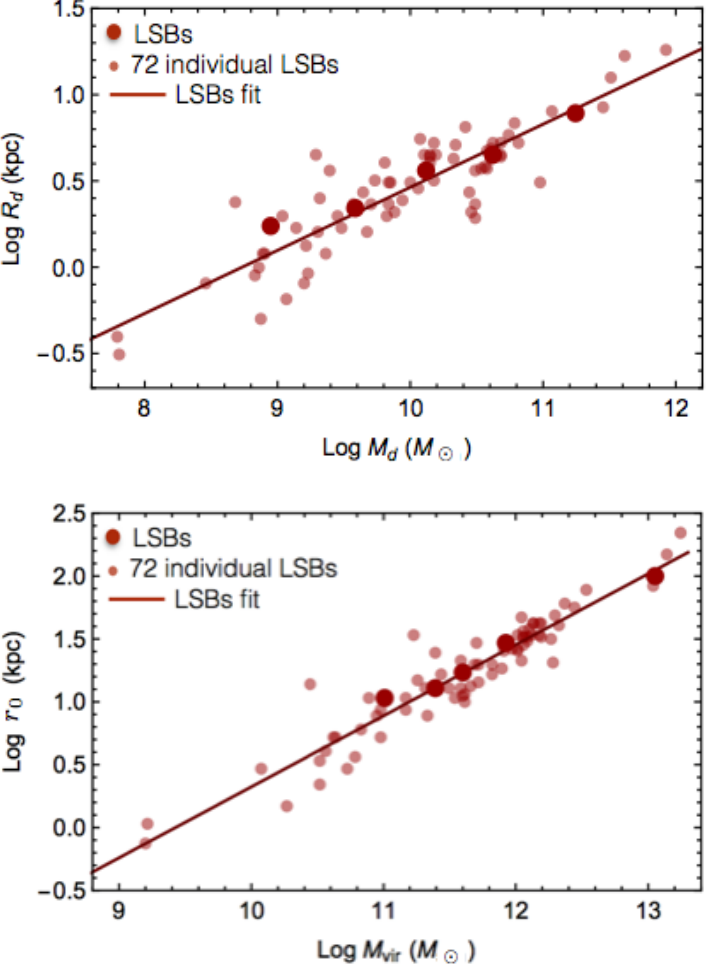
Figure 21. ( up ) Stellar disc length scales vs. stellar disc masses. ( bottom ) DM halo core radii vs. their virial masses. Image reproduced from